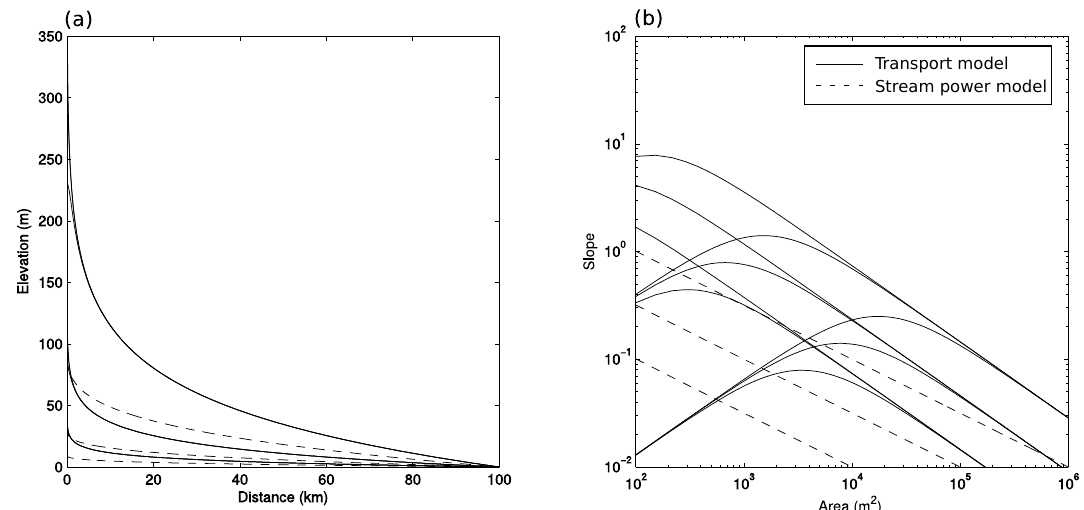
Figure A1. (a) Steady-state profiles of elevation against down-system length and (b) the slope of the profile plotted against the drainage √ area assuming that area a = x p , where p = 1 /h = 2 and h is the Hack exponent. Dashed lines are for the stream power law (Eq. 12) with √ m = 0 . 5 and k = 10 − 4 , 10 − 3 . 5 , and 10 − 3 . The solid lines are for the transport model (Eq. 8 with n = 2, κ = 10 − 3 , 1, and 10 3 m 2 yr − 1 and c = 10 − 6 , 10 − 5 . 5 , and 10 − 5 .